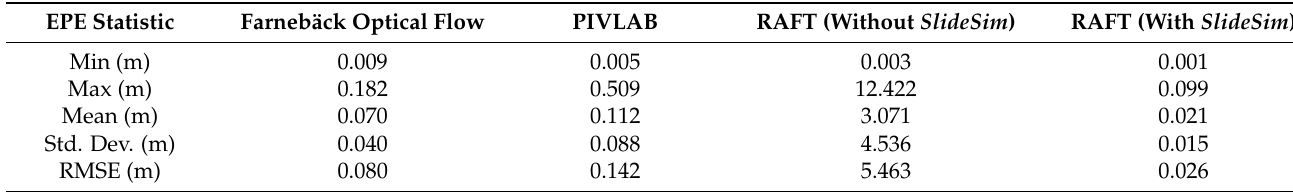
Table 5. 2D Accuracy of select approaches to compute landslide displacement reported as EPE (end point error) in meters compared to ground truth points.